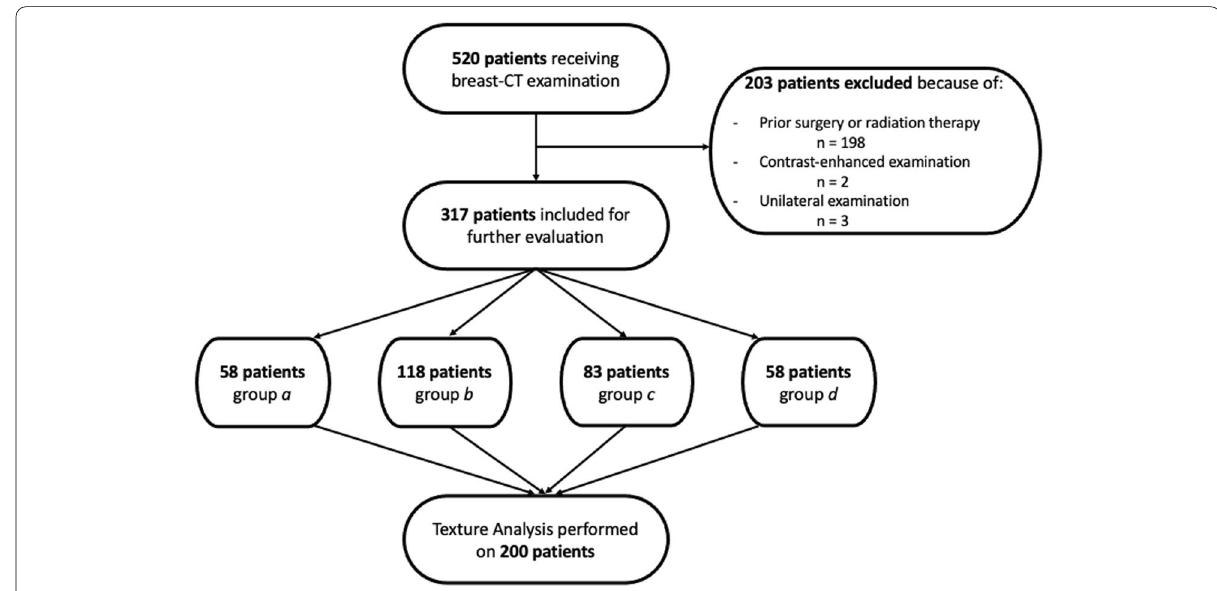
Fig. 1 Flowchart depicting patient selection